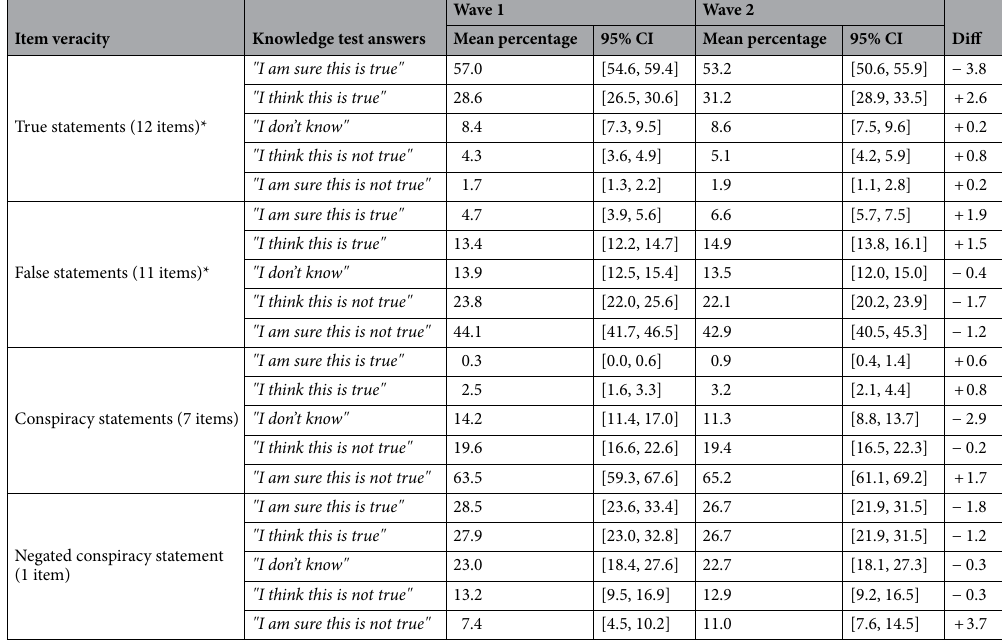
Table 7. Comparison of COVID-19 knowledge test answers between wave 1 and wave 2 (Within-group and Identical Items Only; N = 326). This table shows comparative descriptives of the COVID-19 Knowledge Test of Wave 1 (March 27, 2020) and Wave 2 (July 1, 2020). The percentages are based on a subset of participants that participated in both surveys. The items that were not presented to participants in Wave 1 were removed. One item of the false items was moved to the correct statement category in Wave 2, and therefore also removed from this comparison. Differences in percentages that show overlap between CIs are presented in grey font